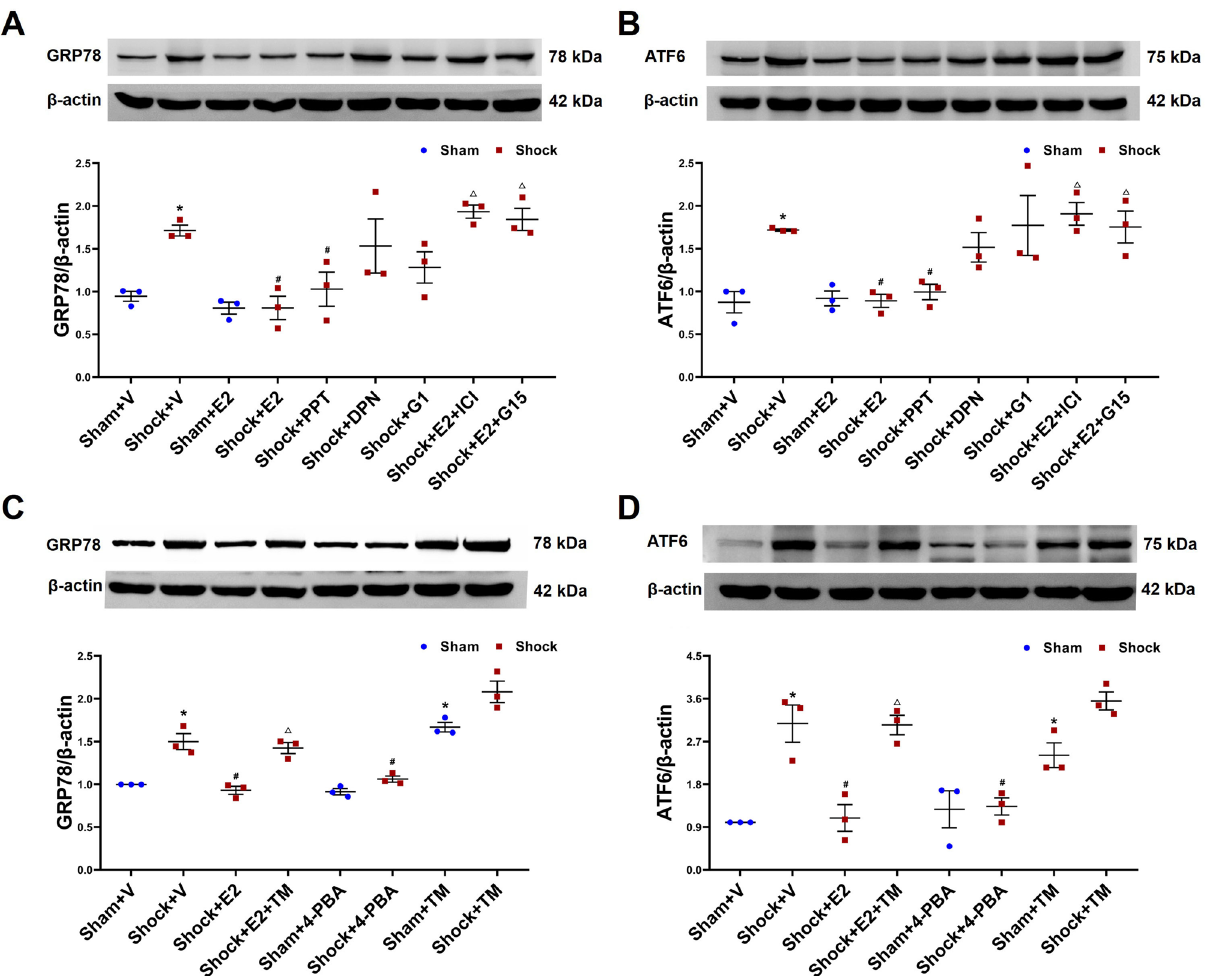
Figure 4. Expressions of GRP78 and ATF6 in spleen. The spleens were harvested from the rats at 3 h after resuscitation or each time and treated with vehicle (V), 17-estradiol (E2), propyl pyrazole triol (PPT), diarylpropionitrile (DPN), G-1, E2 and ICI 182,780 (E2 + ICI), E2 + G15, 4-Phenylbutyric acid (4-PBA), tunicamycin (TM), E2 + TM, respectively. Subsequently, the proteins were extracted and the GRP78 and ATF6 expression were analyzed with the method of Western blotting. GRP78 and ATF6 blots obtained from 3 rats were analyzed using densitometry, and densitometric values were normalized to β-actin and are shown as means ± SD. The figures showed the representative cropped images of western blot analysis of GRP78 and ATF6. Original blots are presented in Supplementary Fig. S1 and Fig. S2. *p < 0.05 vs. the sham + vehicle group, #p < 0.05 vs. the shock + vehicle group, △ p < 0.05 vs. the shock + E2